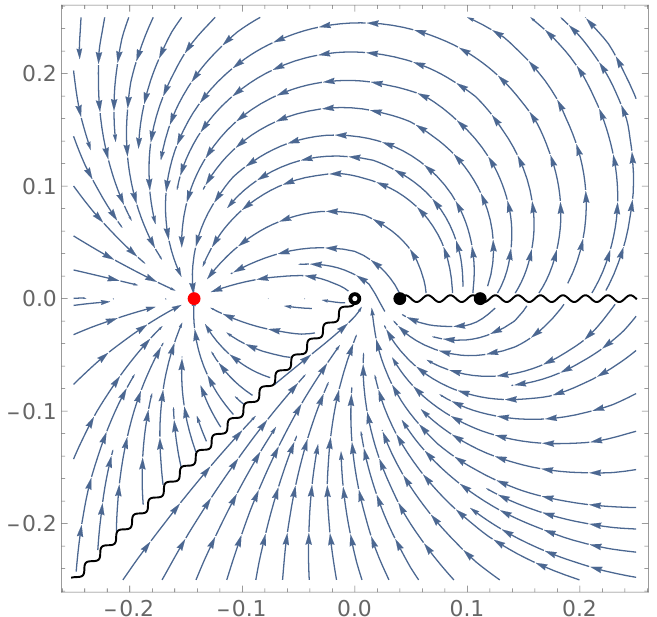
Figure 2 . Attractor (cid:13)ow associated to the charge vector Q = (4 ; (cid:0) 15 ; (cid:0) 5 ; 0) T in the ’ -plane. The red dot represents the attractor point ’ = (cid:0) 1 = 7, the hollow black dot is the large complex structure point ’ = 0 and the solid black dots represent the two nearest conifolds at ’ = 1 = 25 and ’ = 1 = 9. The (cid:13)ow lines are discontinuous across branch cuts which illustrates the fact that the (cid:13)ow takes place on a Riemann surface that is a multi-sheeted cover of the ’